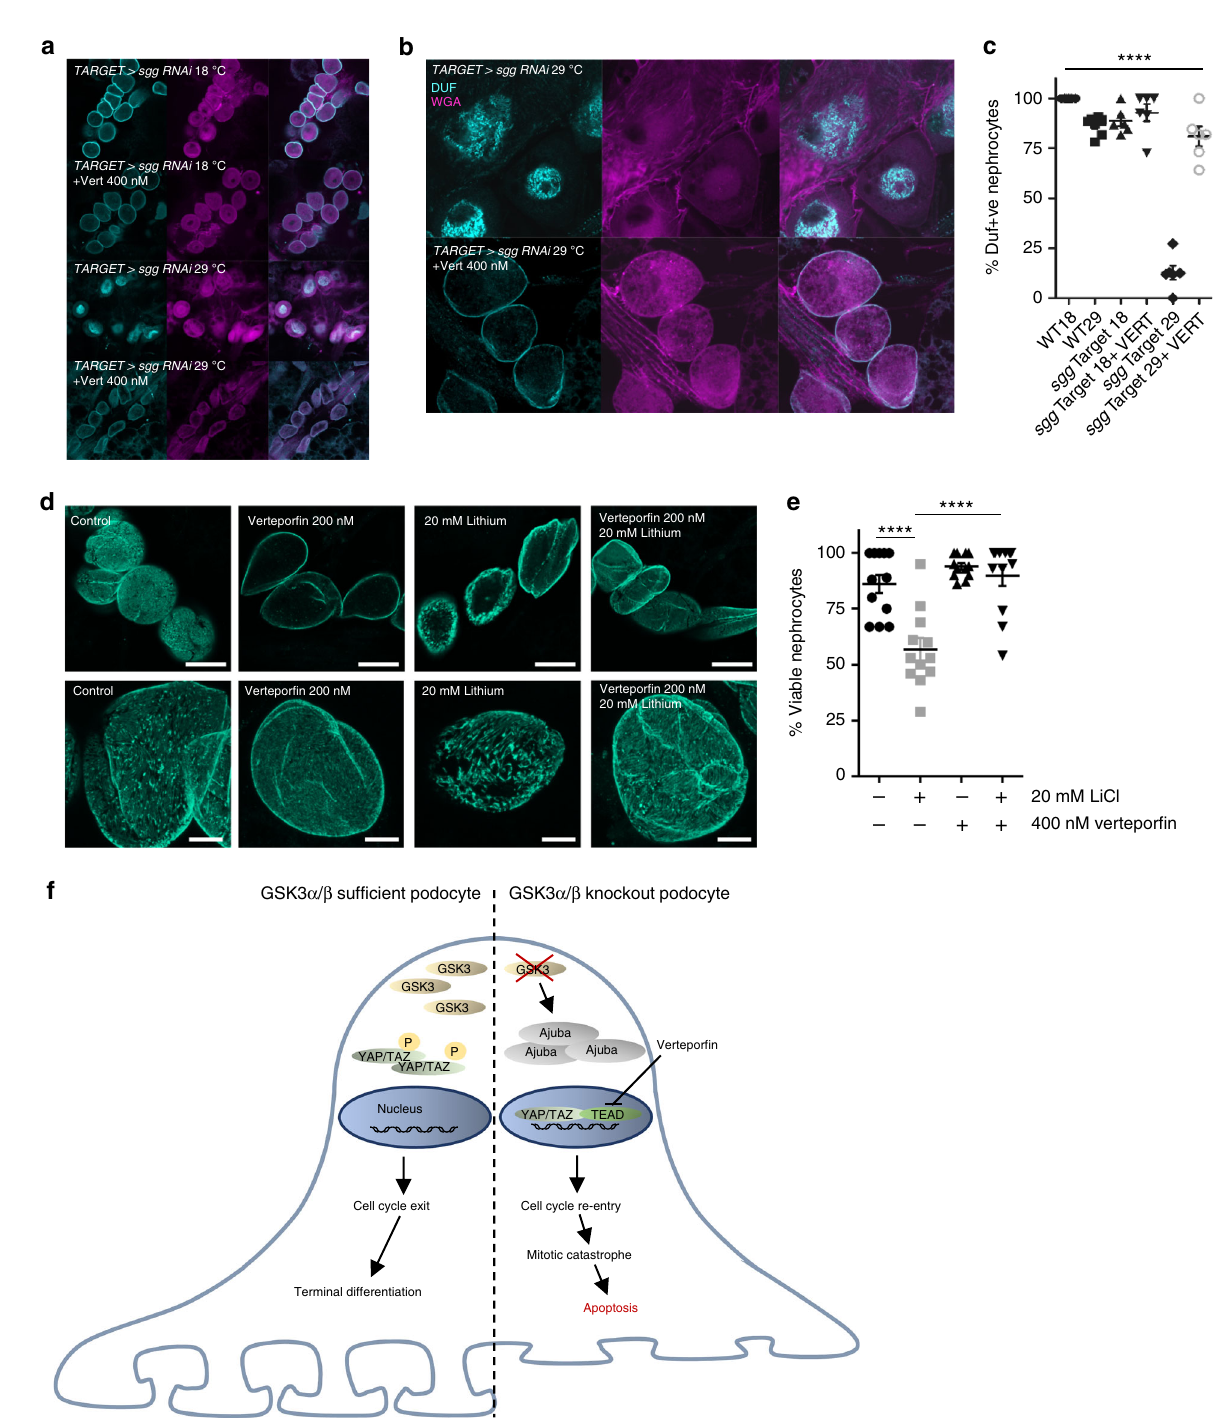
and GANT61(R and D Systems) were applied at the concentrations indicated during a 7-day incubation following 24-hour transduction of GSK3 α / β fl oxed cells with Cre recombinase expressing lentivirus. Cells were stained with Hoechst (Sigma) at 1µg/ml, imaged, using an IN Cell analyser 2200 (GE Healthcare) and cell number determined using IN Cell analyser workstation software (GE